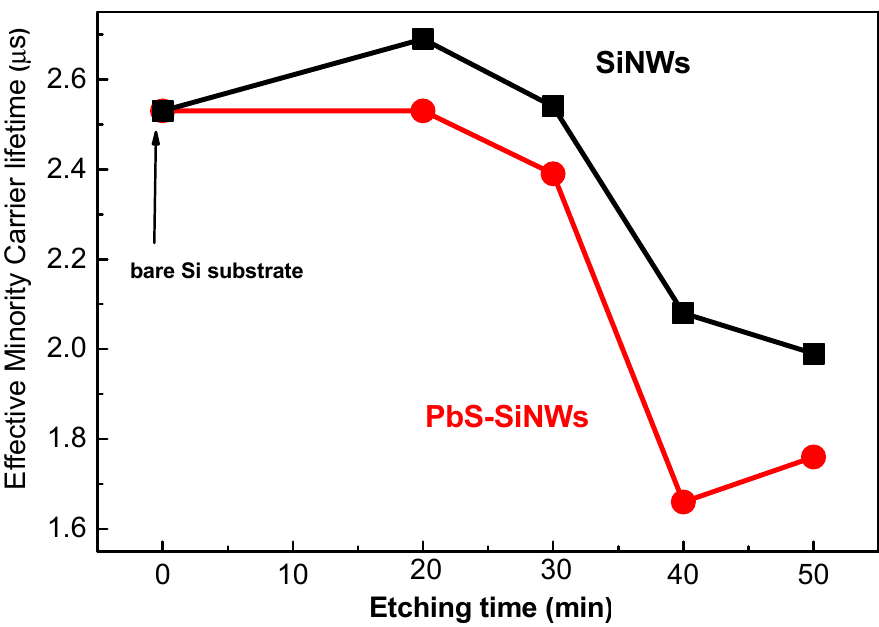
Figure 7. Effective minority carrier lifetime of Si substrate SiNWs/Si and PbS/SiNWs/Si measured at a carrier injection rate ( ∆ n) equal to 2 × 10 14 cm − 3 for SiNWs etching time 20, 30, 40, and 50 min. The lifetime measurements are performed at a carrier injection rate ( ∆ n) = 2 × 10 14 cm − 3 . The effective lifetime value ( τ eff ) of the minority carriers of the untreated Si substrate is equal to 2.53 µ s, and it decreases to 1.66 µ s for SiNWs (50 min) decorated with PbS NPs.